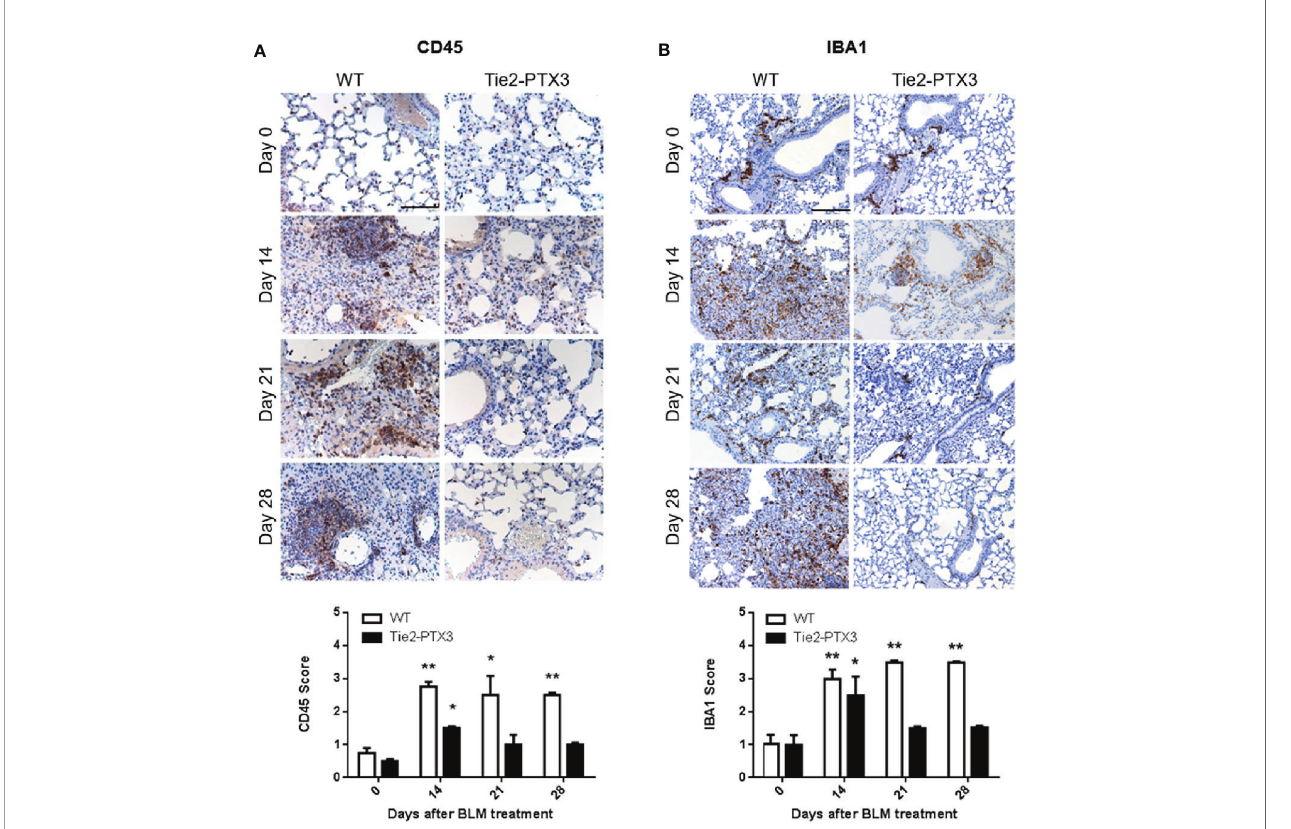
FIGURE 4 | Stromal PTX3 overexpression prevents immune in fi ltration in BLM-induced lung fi brosis. CD45 (A) and IBA1 (B) levels in the lungs of wild type (WT) and transgenic Tie2-PTX3 mice treated with bleomycin (BLM) were assessed by immunohistochemistry and quanti fi ed by scoring the immunostaining. N = 5 – 8 mice/ group; scale bar = 100 µm (A) , 200 µm (B) ; *P < 0.05; **p <